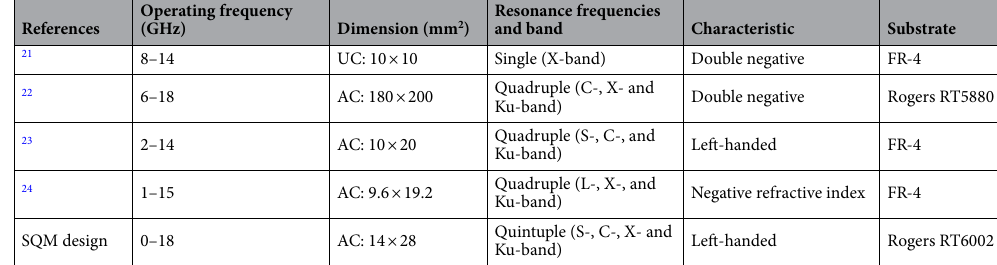
Table 4. Comparison between the proposed metamaterial design and previous studies. UC Unit cell, AC array cell